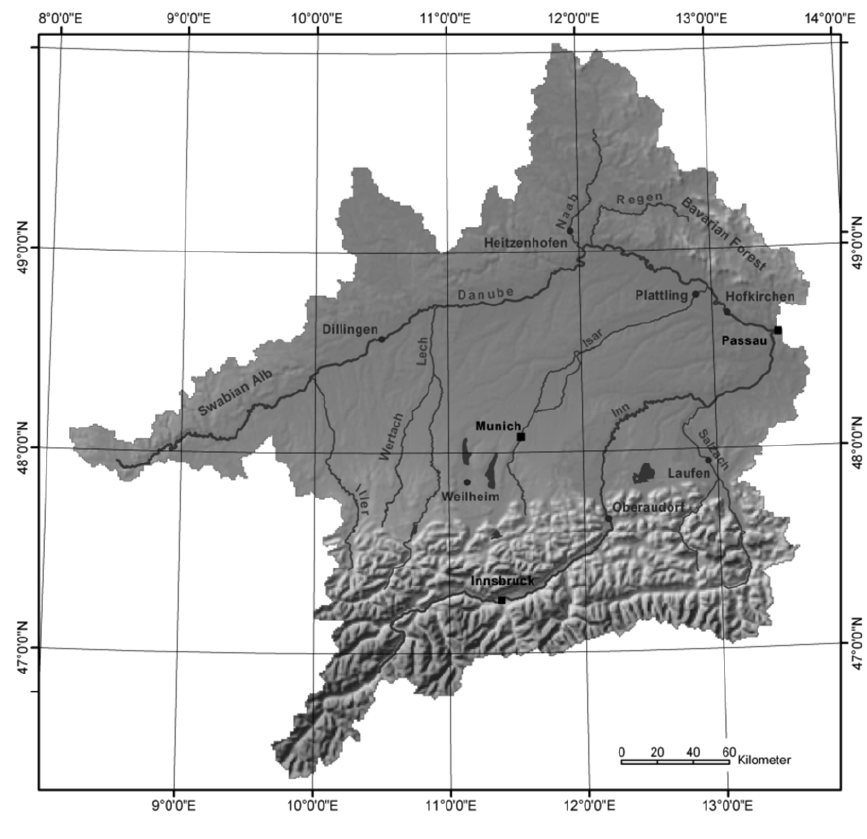
Fig. 1. The Upper Danube